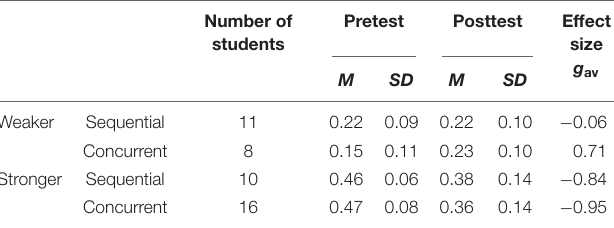
learning gains [paired samples t -tests: sequential: t (20) = −